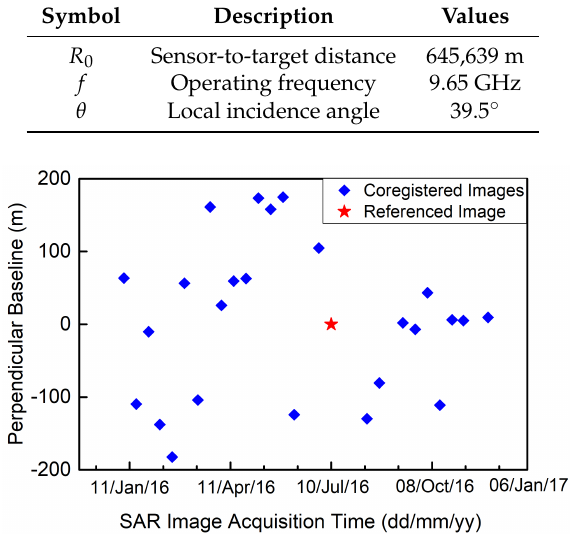
Figure 2. Spatial/temporal baseline of SAR image acquisition. The red star represents the master image, while blue diamonds show the slave